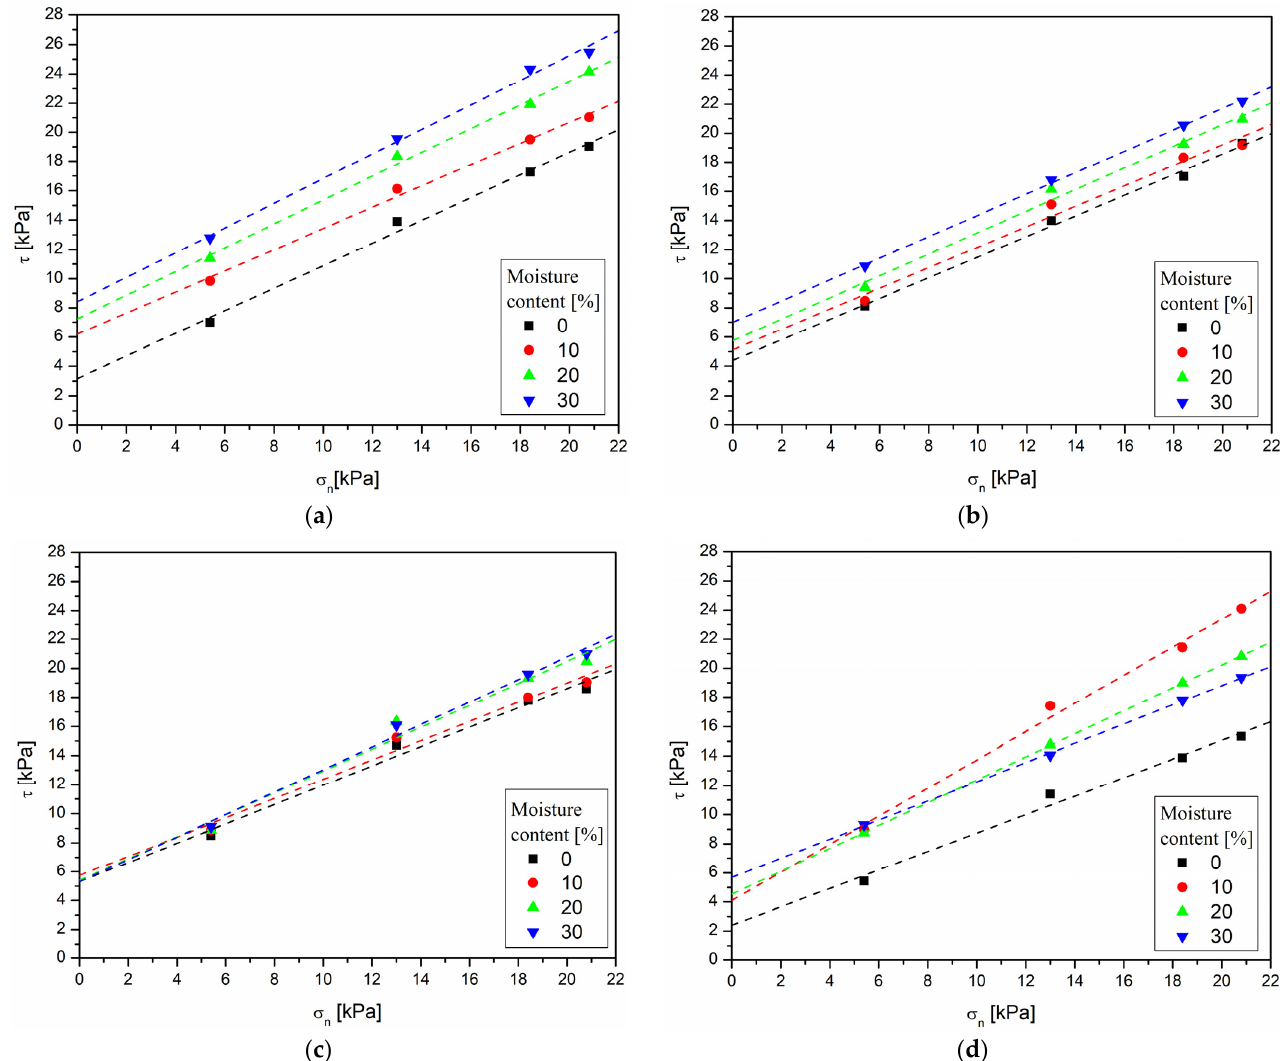
Figure 7. Effect of moisture content on yield loci for: ( a ) mixture of HC 95%, DDGS 5%; ( b ) mixture of HC 70%, DDGS 30%; ( c ) mixture of HC 40%, DDGS 60%; ( d ) DDGS. of HC 70%, DDGS 30%; ( c ) mixture of HC 40%, DDGS 60%; ( d )